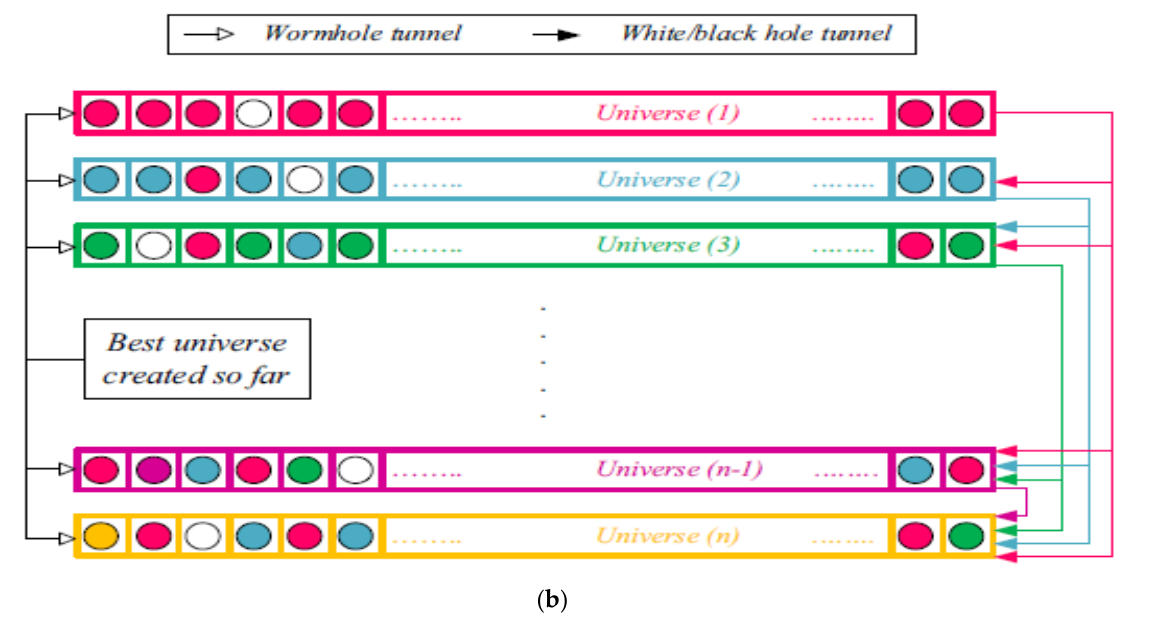
Figure 6. ( a ) Representation of white, black, and wormholes in a solution space; ( b ) the principle of the multi-verse optimizer (adapted from [45]).